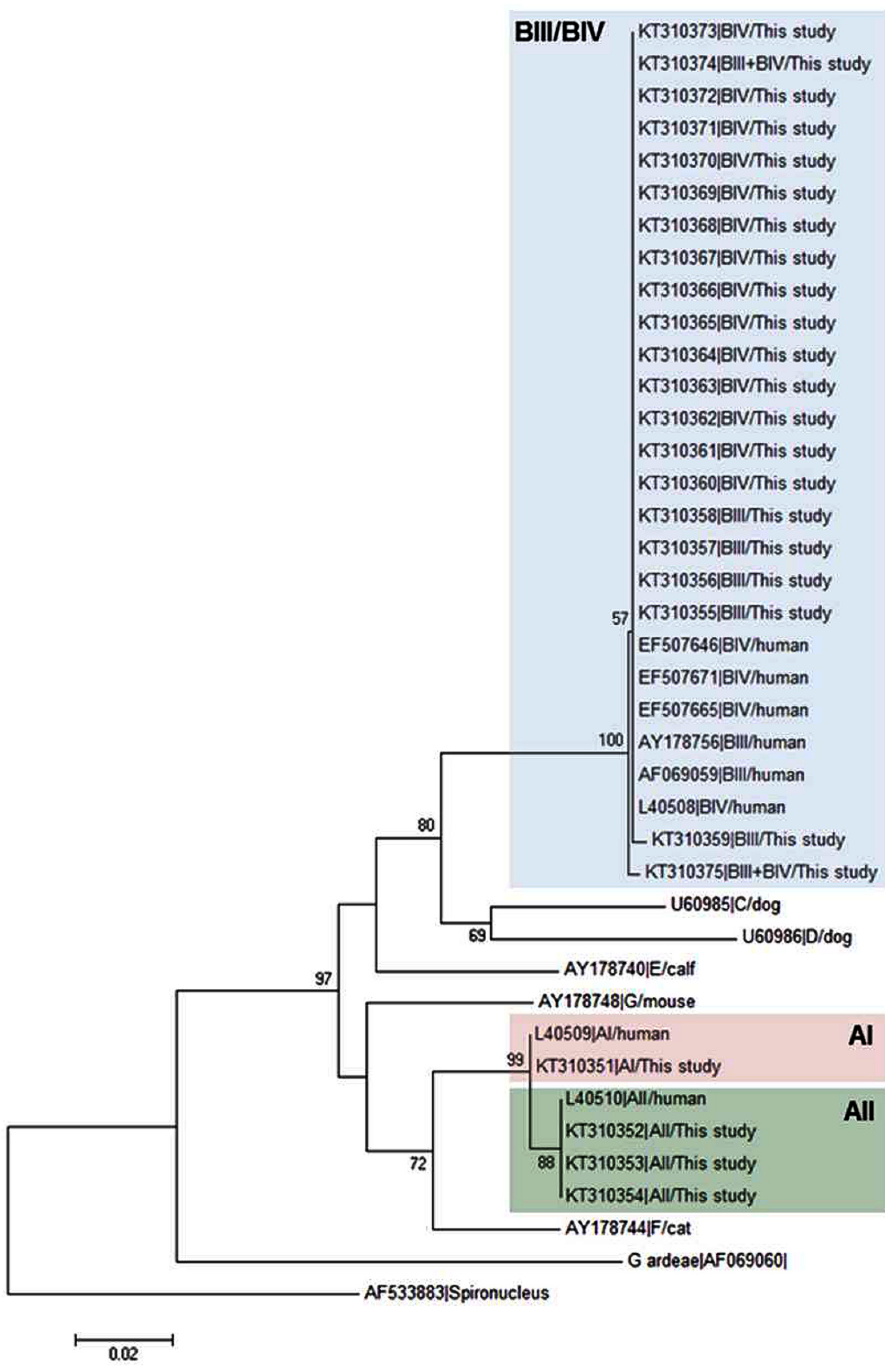
Fig 1. Evolutionary relationships among assemblages of G . duodenalis at the GDH locus inferred by a neighbour-joining analysis of the nucleotide sequence covering a 359-bp region (positions 103 to 461 of GenBank accession number L40508) of the gene. GenBank accession numbers are provided for each sequence used. The bootstrap consensus tree was inferred from 1,000 replicates. Branches corresponding to partitions that were reproduced in less than 50% of bootstrap replicates are collapsed. The bootstrap values are indicated at the branch points. The evolutionary distances were computed using the Kimura 2-parameter method. The rate variation among sites was modelled with a gamma distribution (shape parameter = 2). Spironucleus vortens was used as outgroup taxa.